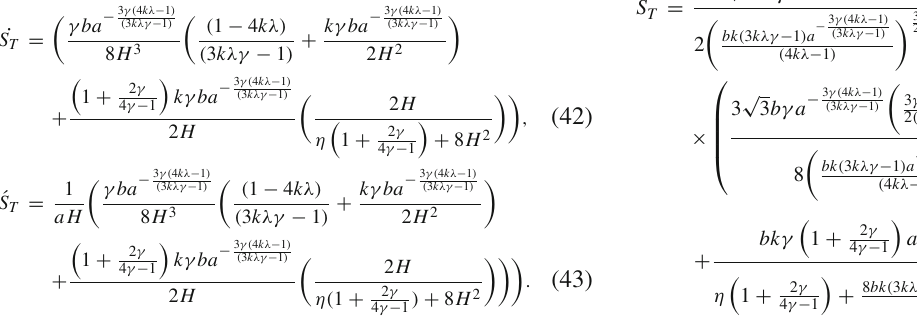
(cid:7)(cid:7) S T